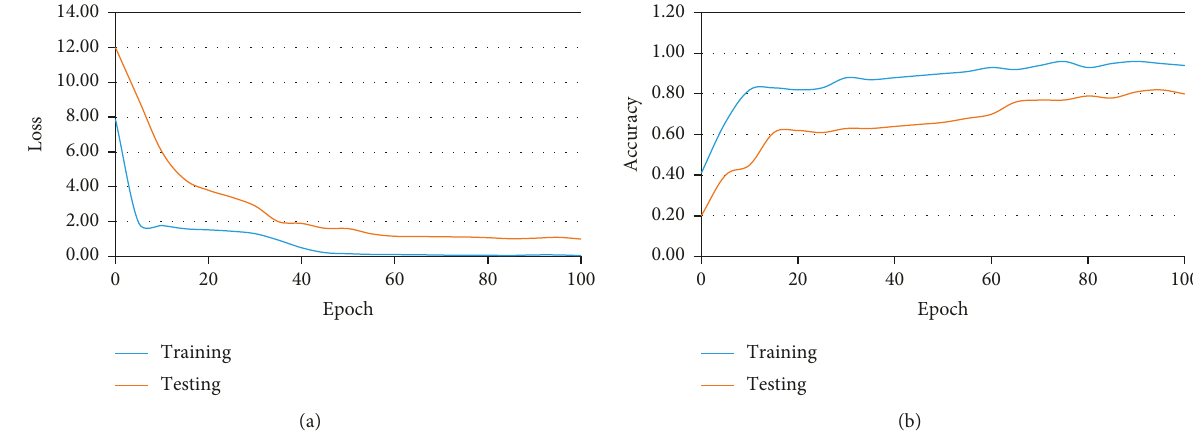
Figure 13: (a) Network loss and (b) network accuracy of the test set.